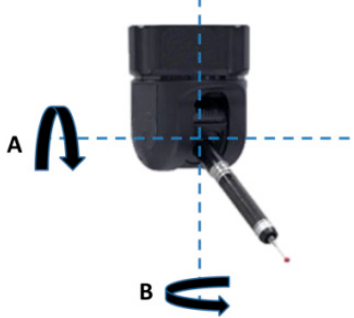
Figure 2. Articulated probe head used in five ‐ axis coordinate systems with revolution axes marked. A : rotation angle along the horizontal axis of the probe head; B : rotation angle along the vertical axis of the probe head.